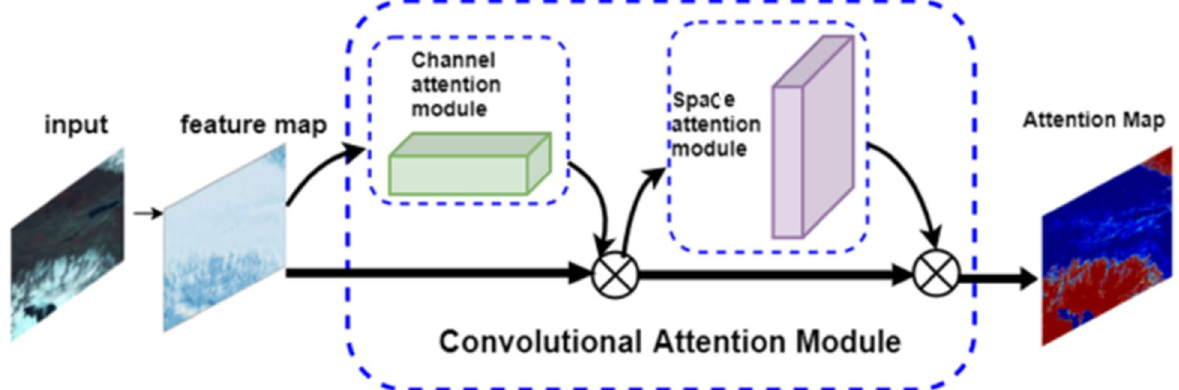
Fig. 8 Different modules and their mapping to edge